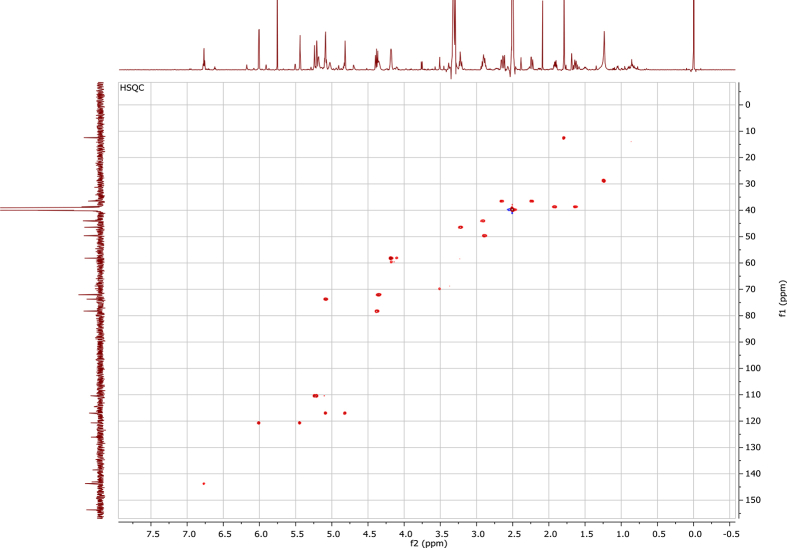
HSQC (DMSO-d6) spectrum of compound 13.